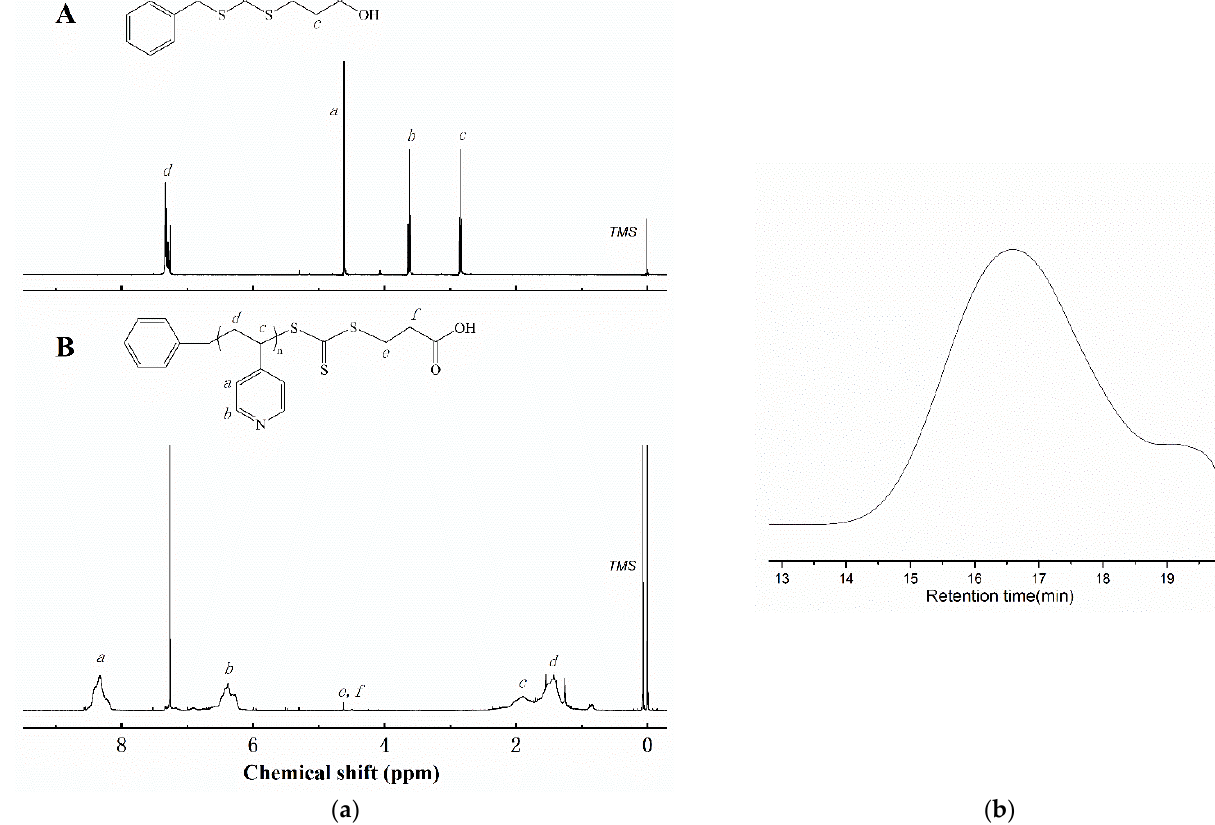
Figure 1. ( a ) 1 H-NMR spectrum of the BSPA (A) and P4VP (B); ( b ) GPC traces of P4VP.